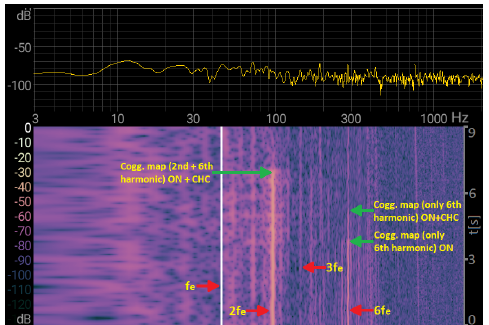
Figure 27. Sound FFT analysis at steady-state ω e = 300 rad algorithm. Approx. 50% of rated load.